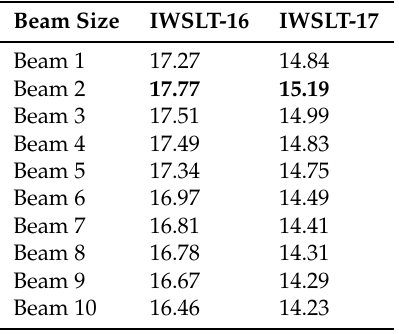
Table 3. Experimental Results according to Beam size.